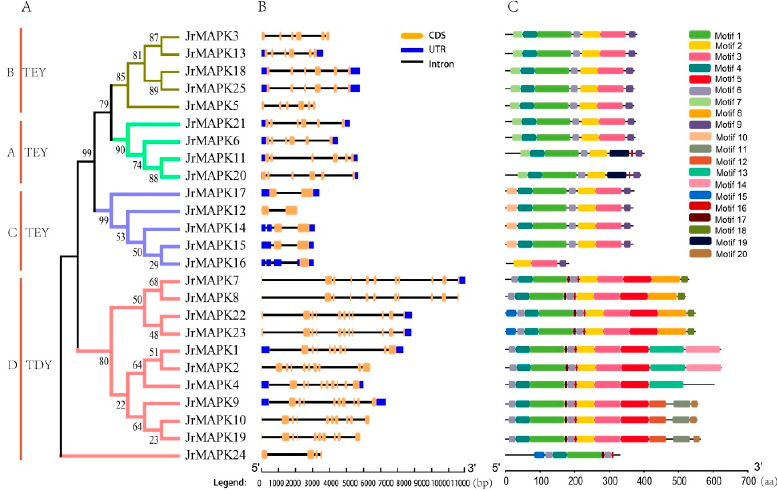
Figure 3. Structure and conservative motif analysis of the JrMAPK genes. ( A ) Phylogentic analysis of MAPK proteins in Juglans. ( B ) The gene structure of MAPK family in Juglans. ( C ) The distribution of conserved motifs in JrMAPK proteins. Each motif is represented by a colored box.